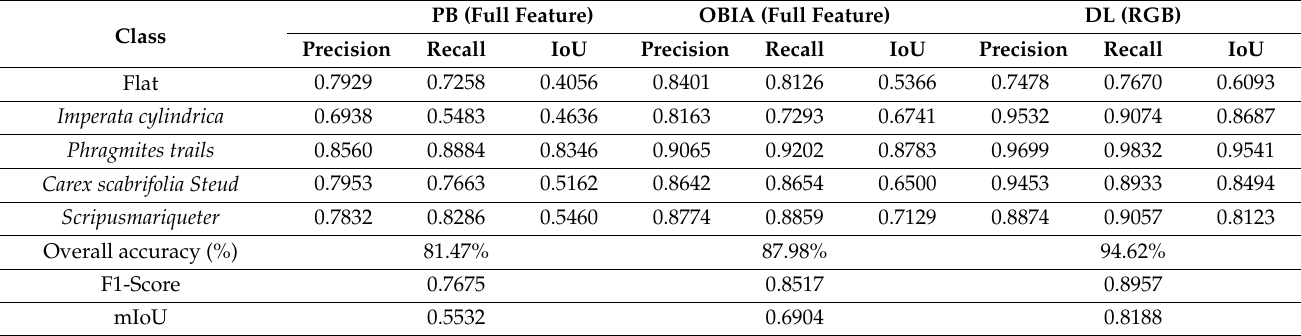
Figure 6. F1-Score, Overall Accuracy, and mIoU of DL models with different data combinations. The comparison of the accuracy evaluation of PB and OBIA classification, after full feature extraction (RGB + VI + Texture + DSM), with the best classification of the DL model is shown in Table 5. Collectively, the mIoU of DL is 0.8188, which is significantly higher than results of the PB and OBIA, indicating that the overall classification perfor- mance of DL is significantly better than that of PB and OBIA. Despite the sufficient fea- ture extraction and object segmentation of OBIA, it still shows a poor classification per- formance with an mIoU of 0.6904, which indicates that there are still some errors com- pared with the ground truth map. This result also demonstrated that there are large dif- ferences between UAV remote sensing classification paradigms. Among them, IoU reached high values for all vegetation classes in the result of DL, and the higher IoU in- dicated that the DL achieved a fine classification result on the vegetation boundary of coastal wetlands. Unexpectedly, the classification performance of the Flat class under the DL model is not satisfactory with an IoU of 0. 6093. The possible reason is that the high tide affects the quality of the labels produced by visual interpretation and therefore af- fects the effectiveness of the DL model. Nonetheless, the IoU of DL was greater than OBIA and DL in all classes, including both plant community and flat. Table 5. Comparison of accuracy assessment of PB, OBIA, and DL classification. The metrics in PB and OBIA classification are the average of 20 iterations under complete feature combination ex- traction (RGB + VI + Texture + DSM) in GEE.